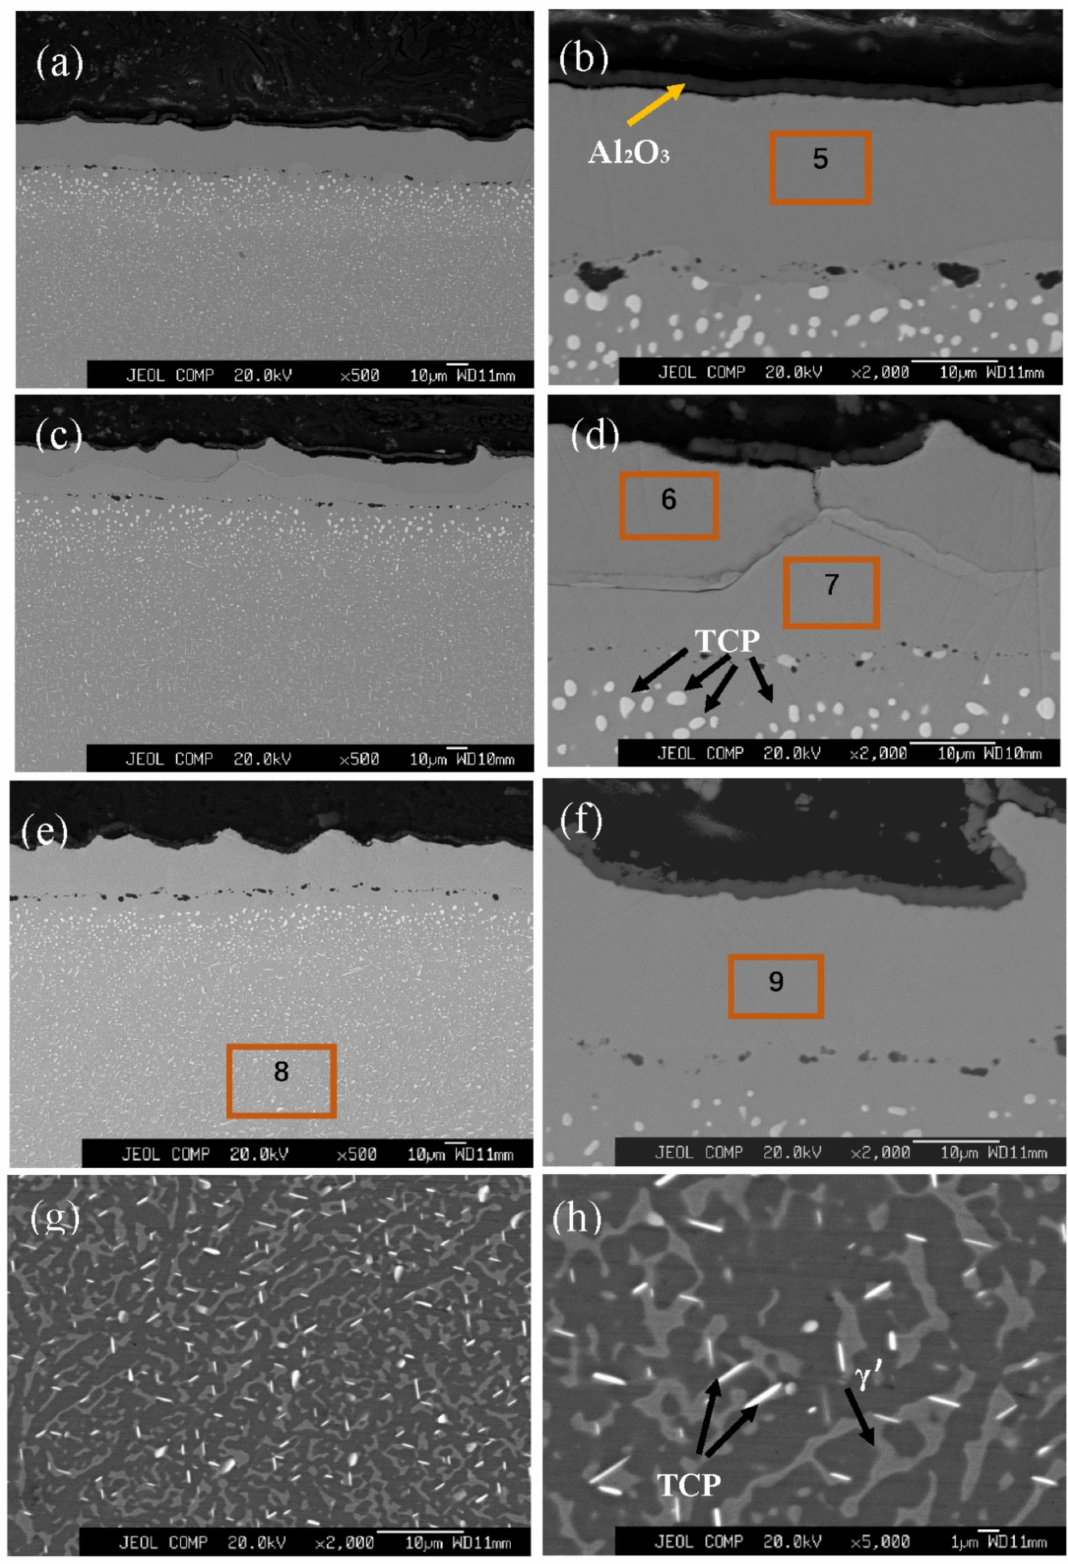
Figure 2. The cross-section morphology of IC21 substrate with coating after 50 h ( a , b ), 150 h ( c , d ), 200 h ( e – h ) after thermal